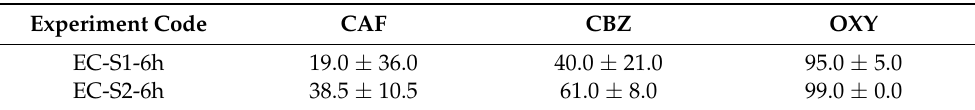
Table 3. Caffeine (CAF), carbamazepine (CBZ) and oxybenzone (OXY) degradation (mean ± standard deviation) in the Set EC experiments using effluents S1 and